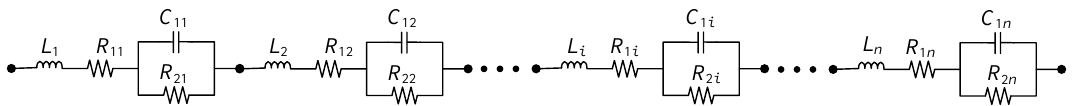
Figure 5. Equivalent circuit associated with complex conjugate pairs.